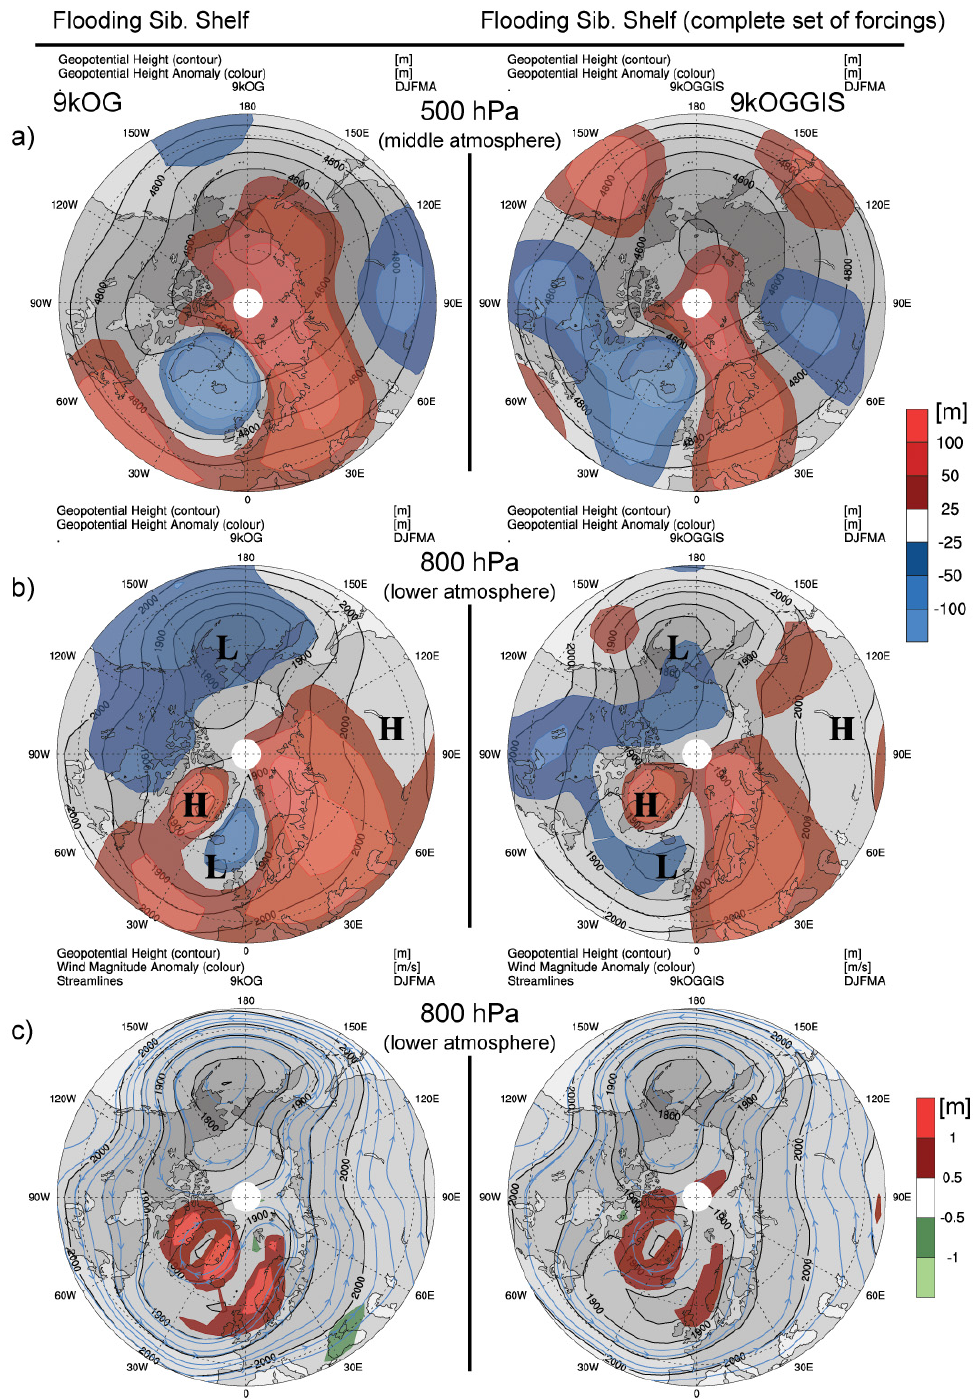
Fig. 7. Atmospheric circulation shown as heights of the 500hPa and 800hPa level. Left column represents results from simulation 9kOG and anomalies to 9kOGSIB, indicating the impact of shelf flooding. Right column shows results from simulation 9kOGGIS and anomalies to 9kOGSIBGIS, indicating again the impact of shelf flooding but with a complete set of forcings (LIS topography and melt water and GIS melt water). (a) upper panel shows middle atmosphere, 500hPa geopotential heights (gray filled contours) and anomalies (coloured contours) of geopotential height. (b) middle panel shows lower atmosphere, 800hPa geopotential heights (gray filled contours) and anomalies (coloured contours) of geopotential height. (c) lower panel shows 800hPa geopotential heights (same as middle panel) and wind magnitude anomalies (coloured contour) as well as